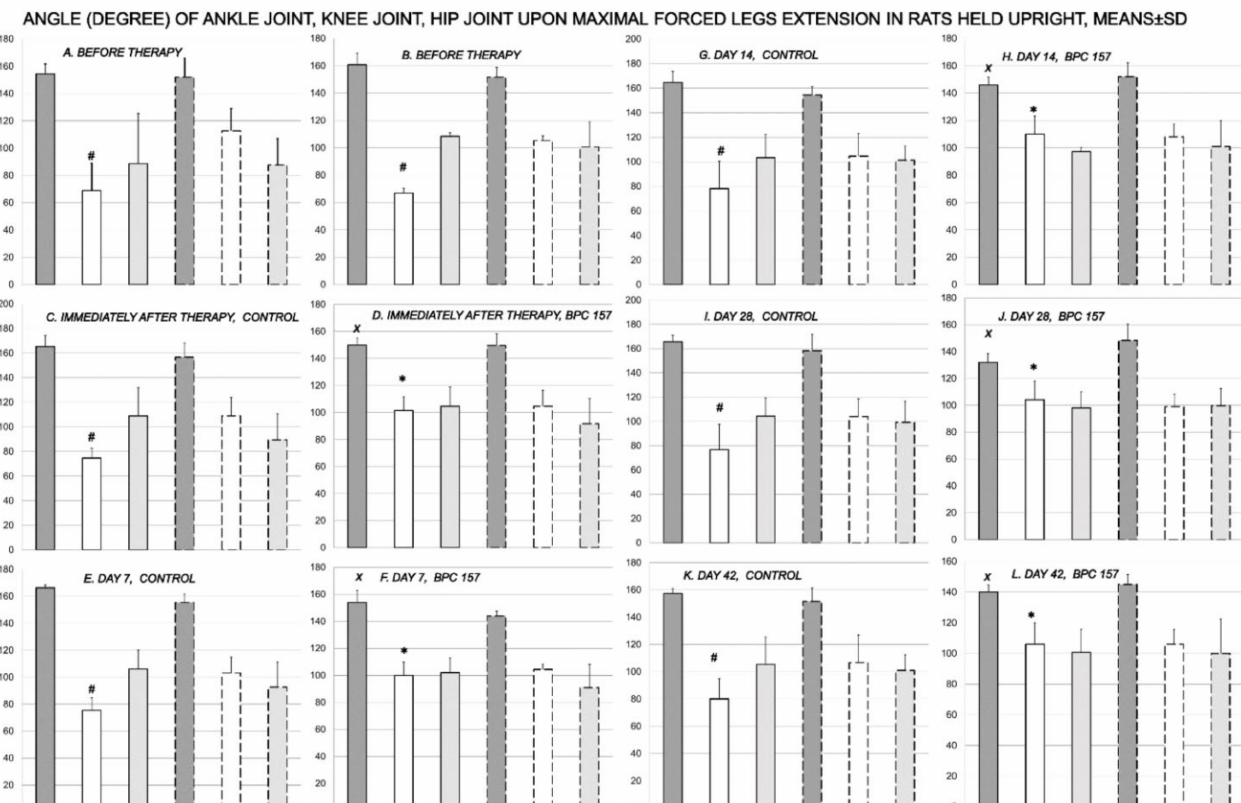
Figure 2. Rats, with the disabled myotendinous junction, were held upright to assess the degree of the angle of the ankle joint (dark gray bars), knee joint (white bars), and hip joint (light gray bars), and to verify injured leg contracture (full bars) in comparison with the non-injured leg (dashed bars), upon maximal legs extension after surgery, but before therapy ( A , B ); and subsequently, immediately after therapy application (control ( C ); BPC 157 ( D )) (day 0), and then at day 7 (control ( E ); BPC 157 ( F )), day 14 (control ( G ); BPC 157 ( H )), day 28 (control ( I ); BPC 157 ( J )) and day 42 (control ( K ); BPC 157 ( L